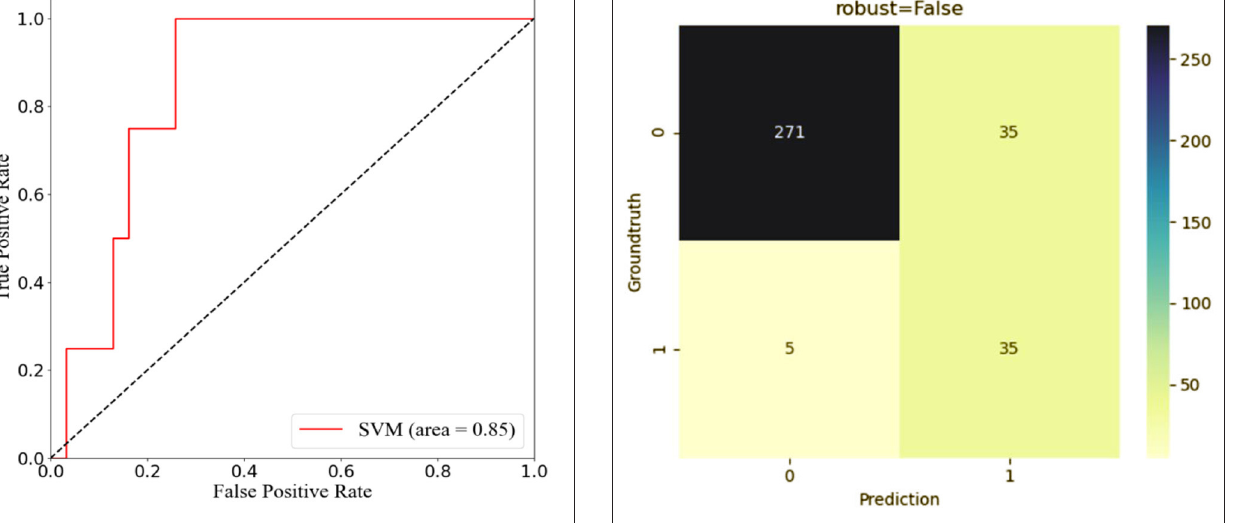
FIGURE 8 | Confusion matrix of SVM